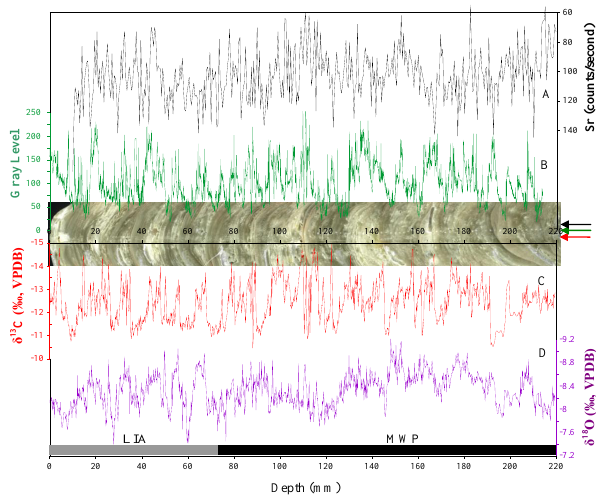
Fig. 5. Comparison between lithologic changes and multi-proxy records of stalagmite BD. (A) Sr record (Counts/Second, black curve); (B) Gray level record (green curve); (C) δ 13 C record (red curve); (D) δ 18 O record (purple curve). The sample photo is shown in the center for comparison. The black, green and red arrows indicate the analysis tracks of Sr, gray level and stable isotope,